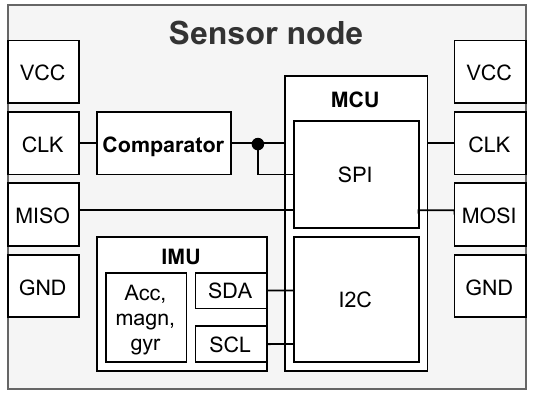
Figure 5. Schematic of a single IMU snsor